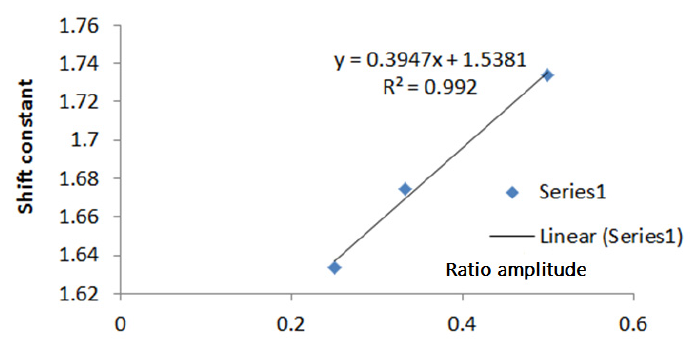
Figure 12. The relation of the shift constants and the amplitude ratio.